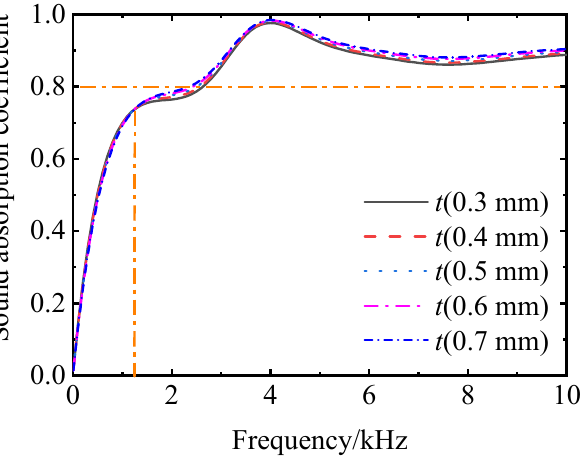
Figure 10. Comparison of α of SSC-HSH corresponding to different honeycomb thicknesses.